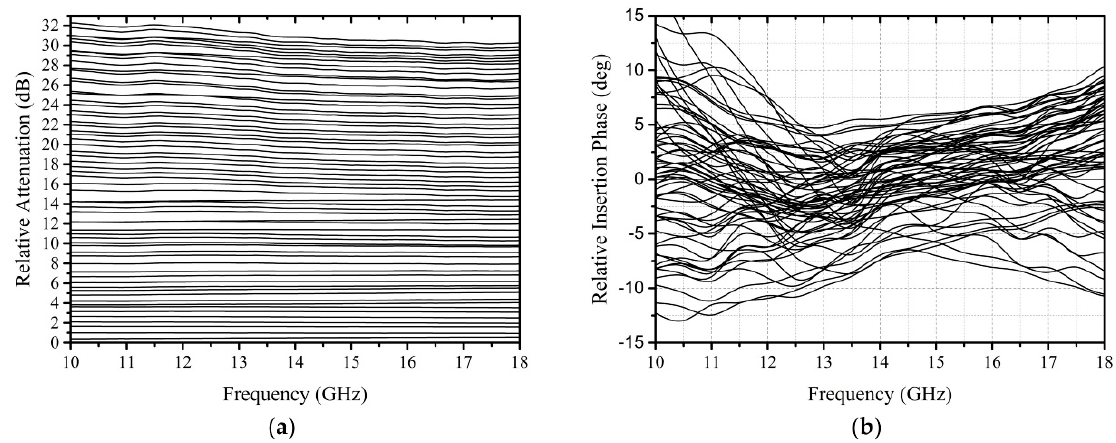
Figure 13. ( a ) The measured 64-state relative attenuation of the proposed attenuator; ( b ) the measured 64-state relative insertion phase of the proposed Figure 13. The measured 64-state relative attenuation and phase of the proposed attenuator.